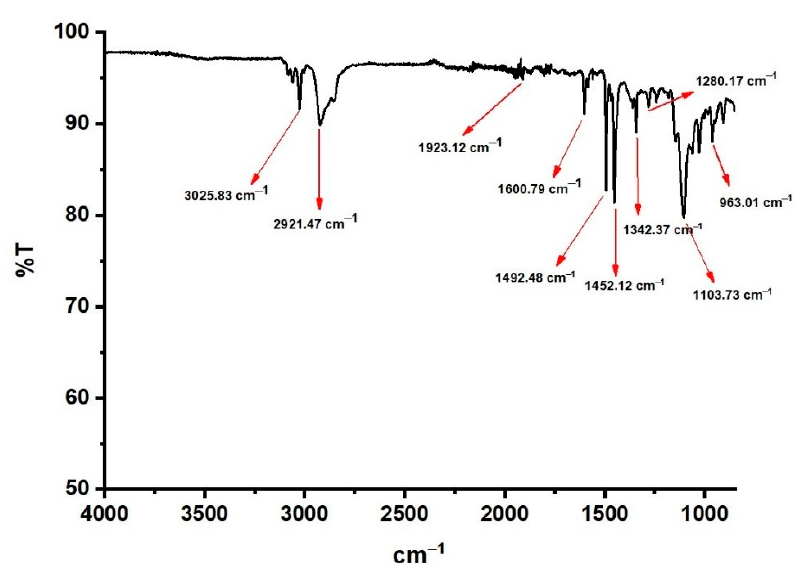
Figure 3. The FTIR spectrum of the PS-b-PEG Block Copolymer acquired by the S polymerization with PEG Macro Crosslinker. with PEG Macro